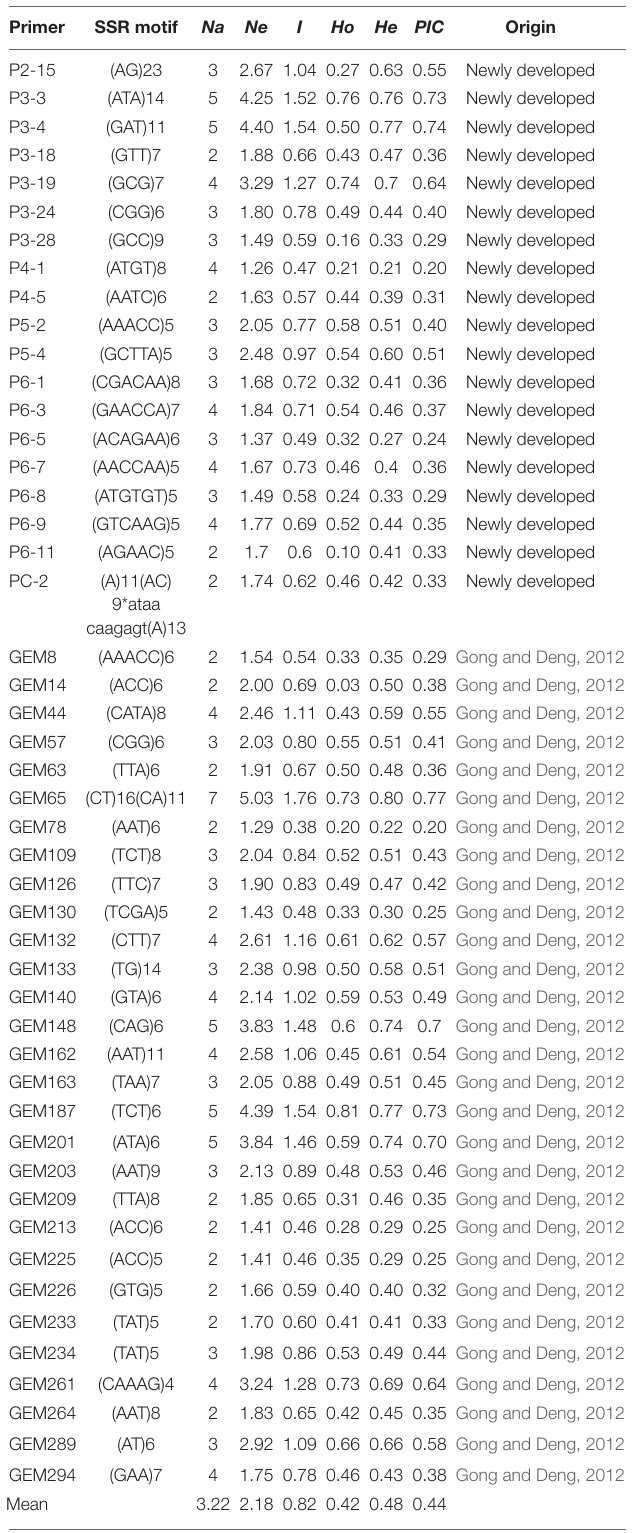
Na, number of allele; Ne, number of effective allele; I, Shannon’s index; Ho, observed heterozygosity; He, expected heterozygosity; PIC, polymorphic information